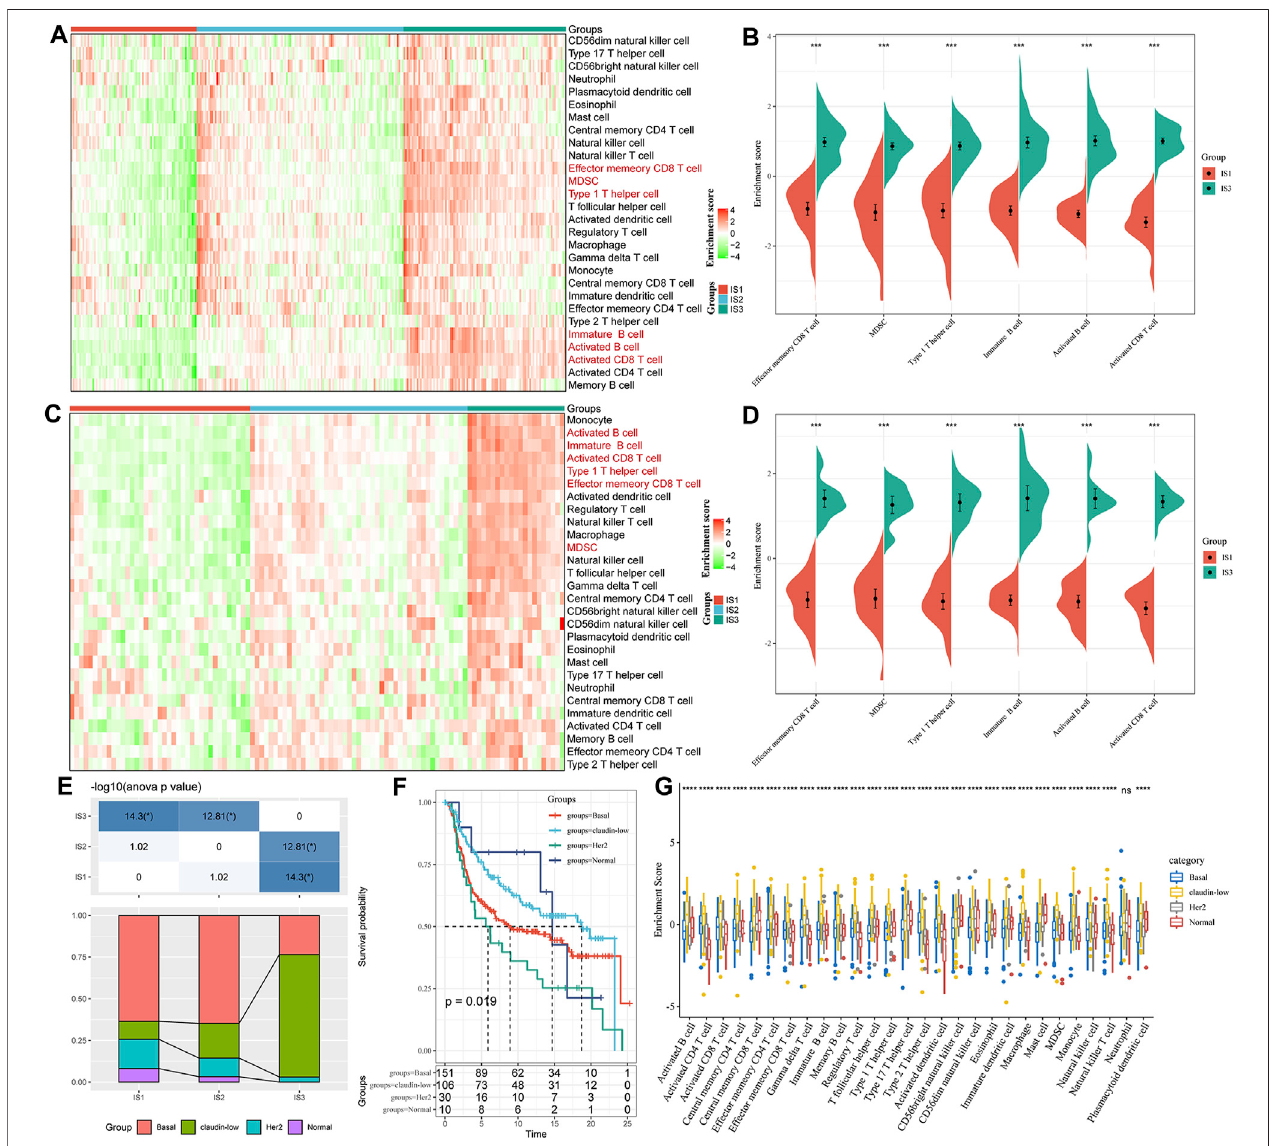
FIGURE 4 | (A) Enrichment score difference of 28 immune cells among immune subtypes in the METABRIC-TNBC cohort. (B) There are several immune cell enrichment scores with signi fi cant differences between good and poor prognosis subtypes in the METABRIC-TNBC cohort. (C) Enrichment score difference of 28 immune cells among immune subtypes in the GSE58812 cohort. (D) There are several immune cell enrichment scores with signi fi cant differences between good and poor prognosis subtypes in the GSE58812 cohort. (E) Intersection of three immune subtypes with PAM50 molecular subtypes. (F) Survival analysis of the PAM50 analysis subtype. (G) Distribution of 28 immune cell enrichment scores in the three immune